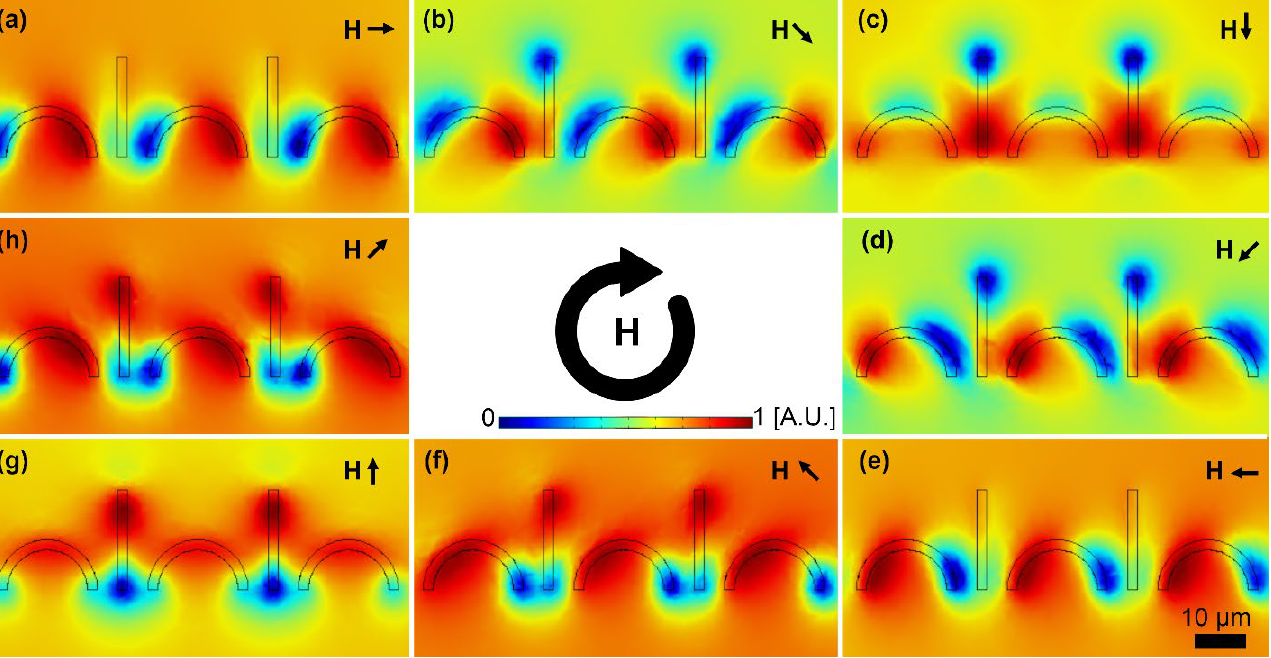
Figure 3. The potential energy distributions for various magnetic field angles, when the field rotates a cycle, are presented. In this figure, the small black arrows stand for the magnetic field directions. The field is rotating clockwise and the steps ( a – h ) are 45°. The energies are plotted at the center of a particle with a radius of 2.5 µm. The blue and red areas indicate the regions with low and high potential energies, respectively.